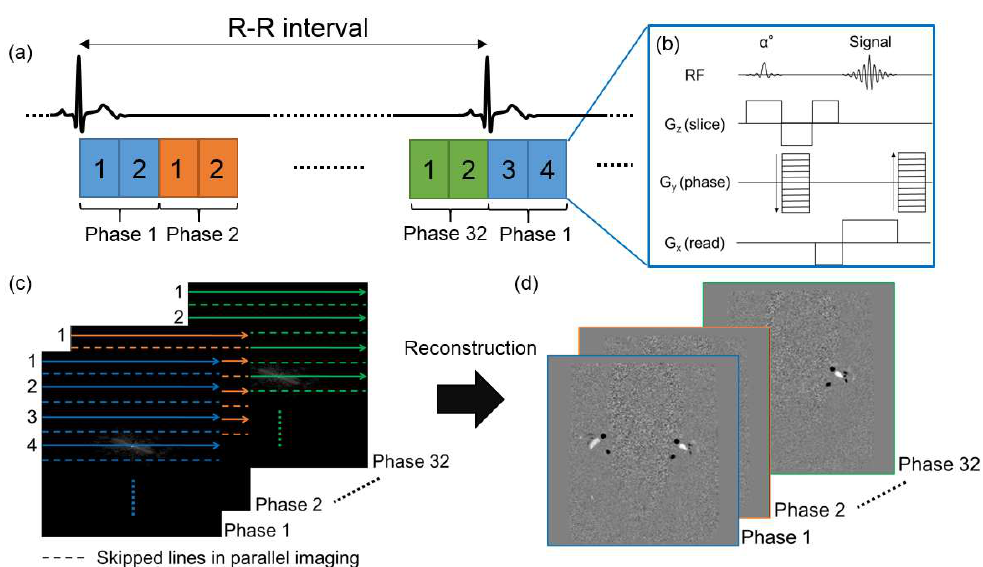
Figure 1. Schematic of fast electrocardiogram (ECG)-synchronized phase-contrast (PC) cine MRI with parallel-imaging and segmented k-space techniques. Each rectangle in ( a ) shows ( b ) PC gradient-echo sequence. ( c ) With a view per segment of 2, two phase-encoding lines are continuously acquired for each temporal phase, and filled in k-space with parallel-imaging acceleration factor of 2. ( d ) Velocity-mapped phase images are reconstructed.